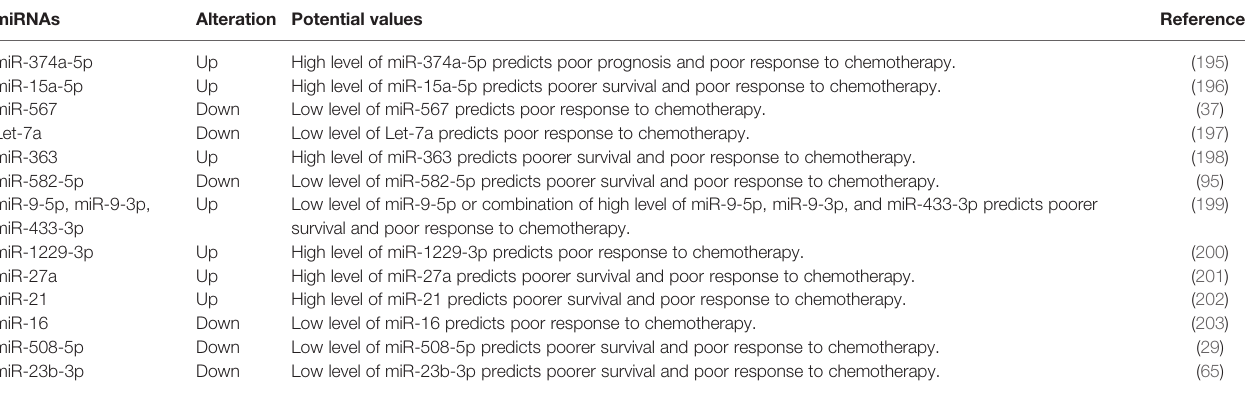
TABLE 4 | Drug resistance-related miRNAs as diagnostic and prognostic biomarkers in GC. miRNAs Alteration Potential